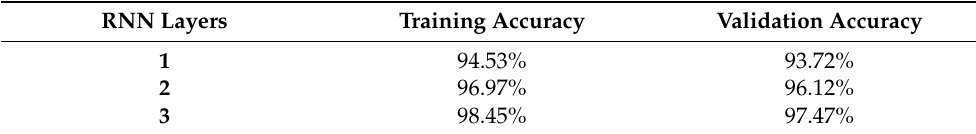
Table 1. Variable layer architectures accuracy